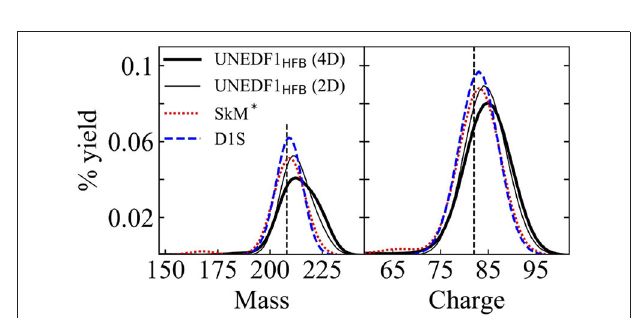
an initial configuration of the fissioning nucleus hardly